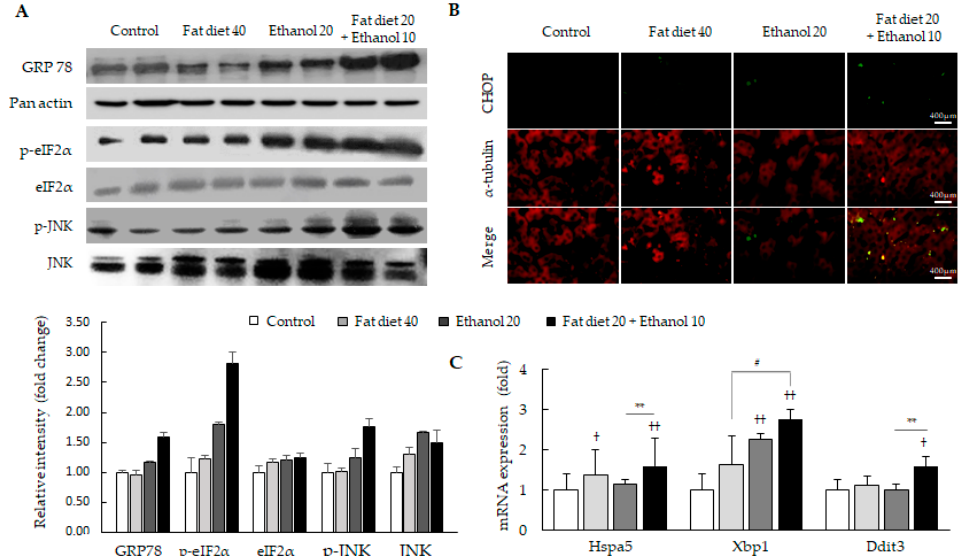
Figure 3. Alterations in hepatic ER stress-related molecules. Western blot and relative intensity analysis of hepatic ER stress-related molecules ( A ), IHC for CCAAT-enhancer-binding protein homologous protein (CHOP) activation ( B ) and mRNA expression of ER stress-related core genes ( C ) are presented. Data are expressed as the mean ± SD ( n = 6). † p < 0.05 and †† p < 0.01 compared with the control group; # p < 0.05 compared with the fat diet 40 group. ** p < 0.01 compared with the ethanol 20 group. The fluorescence signals were detected using a fluorescent microscope ( × 400).